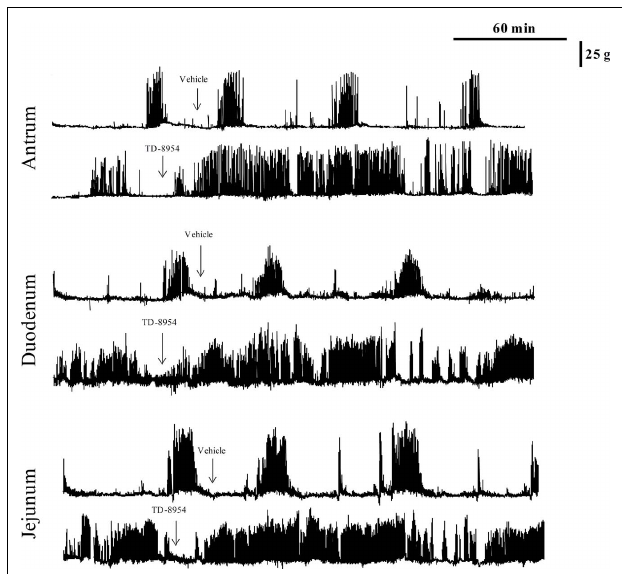
FIGURE 6 | Representative traces demonstrating the effects of oral dosing ofTD-8954 (0.01mg/kg) and vehicle on the contractility of the antrum, duodenum, and jejunum of conscious, fasted dogs.